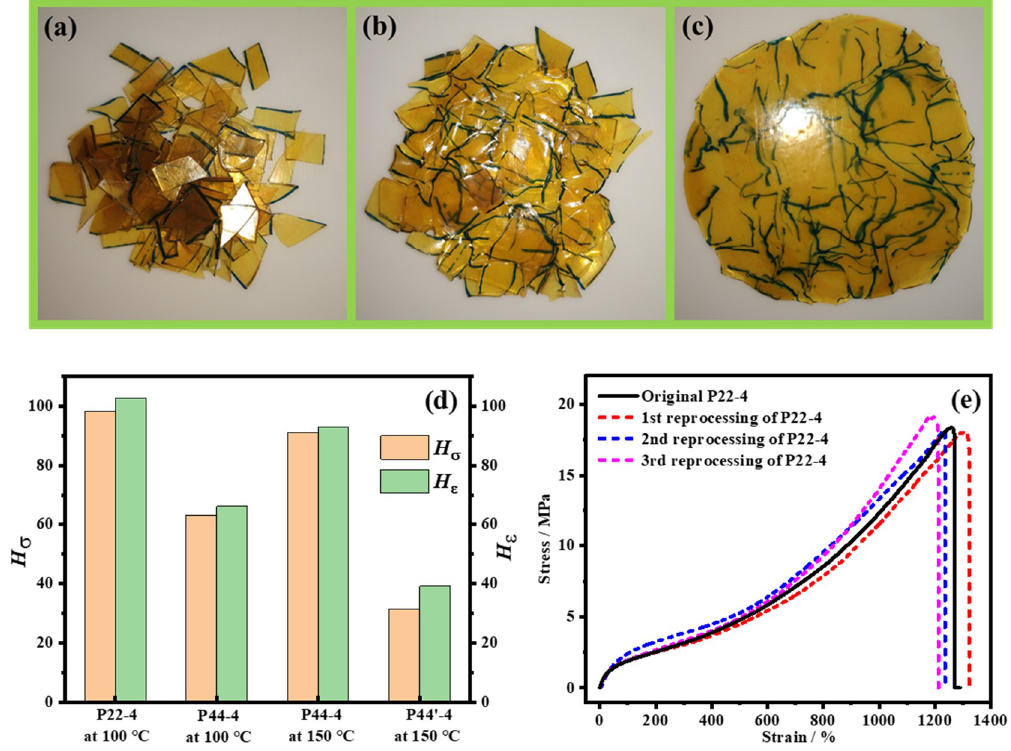
Figure 12. The reprocessing of P22-4. ( a ) Pieces of recycled P22-4. ( b ) Hot-melted P22-4 pieces. ( c ) The regeneration of a P22-4 film after hot-pressing at 100 °C and 0.3 MPa. ( d ) The reprocessing efficiency of the ultimate tensile strength (H σ ) and the elongation at break (H ε ) of P22-4, P44-4, and P44′-4 (without disulfide) after reprocessing at 100 or 150 °C at 0.3 MPa. ( e ) The typical tensile curves of P22-4 following repeated reprocessing by hot-pressing at 100 °C and 0.3 MPa.